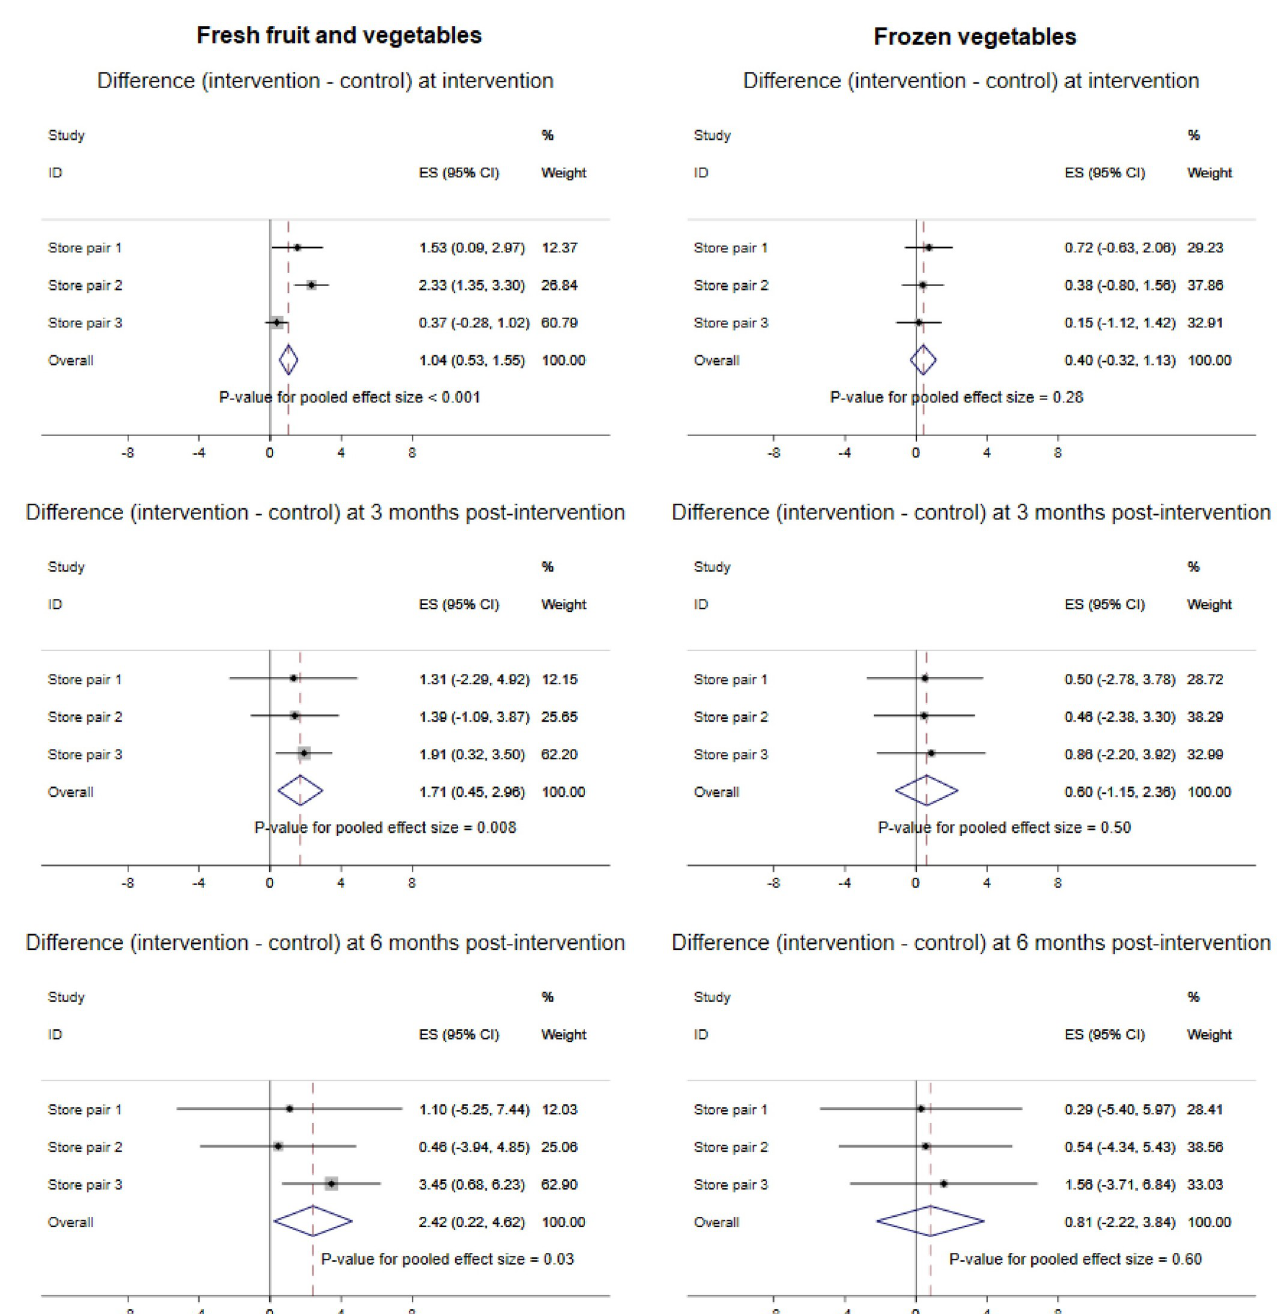
Fig 1. Meta-analysis of total sales of fresh fruits and vegetables and frozen vegetables by store status.